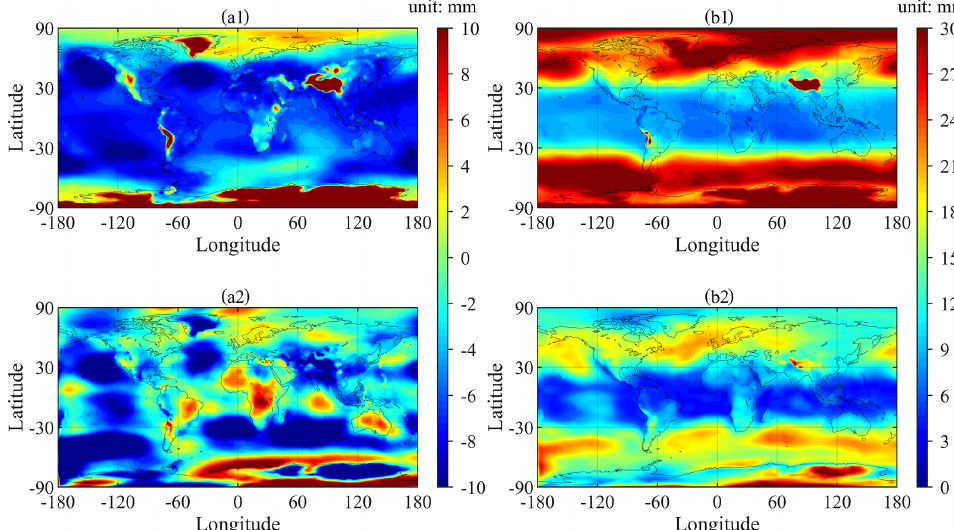
Figure 12. Bias (a1) and RMSE (b1) of ZHD-GPT3 and bias (a2) and RMSE (b2) of ZHD-GZHD over each global grid point (the horizontal resolution: 2 . 5 ◦ × 2 . 5 ◦ ) during the 1-year period of 2020 (reference: ZHD-ERA5).